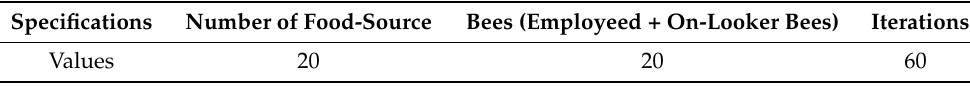
Table 1. Artificial Bee Colony (ABC) algorithm